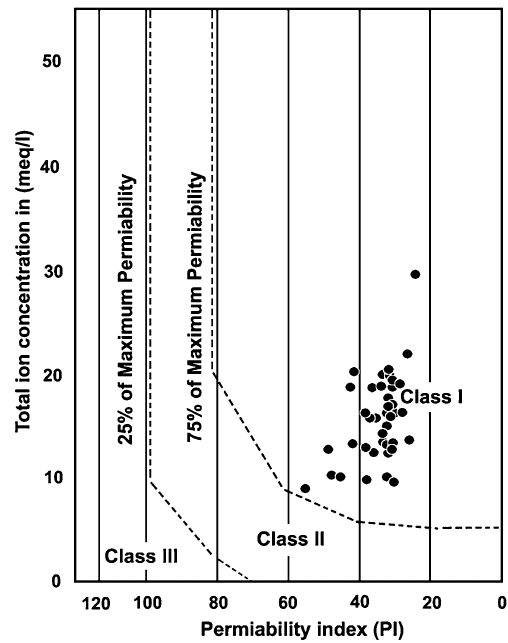
Fig. 7 Doneen’s diagram of groundwater